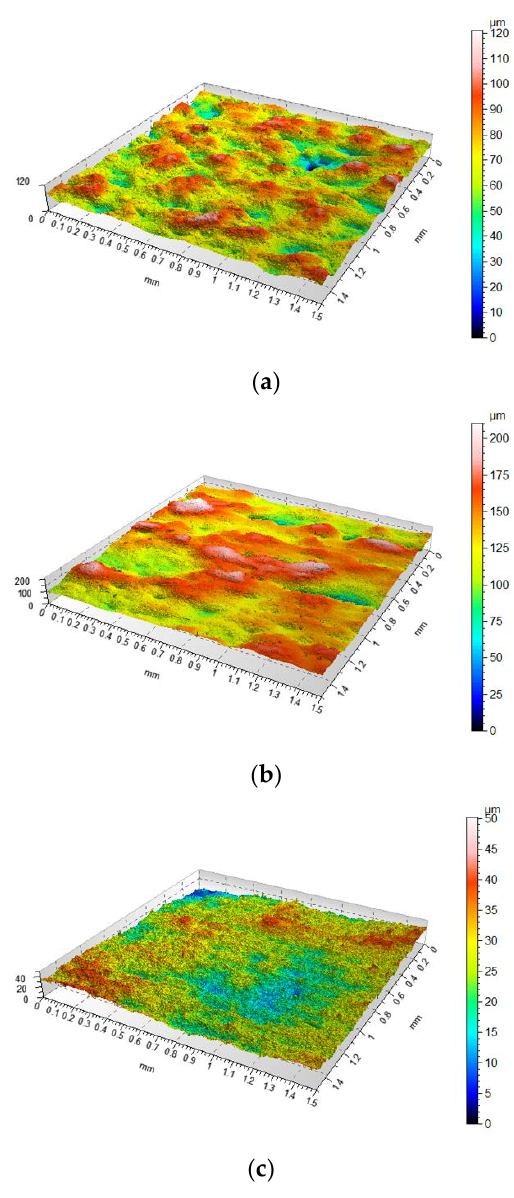
Figure 4. Example isometric view of a surface without modelled morphological features ( a ) 0° ( b ) 45° ( c ) 90°; scales should be analysed carefully. Table 4. Values of selected 3D parameters.